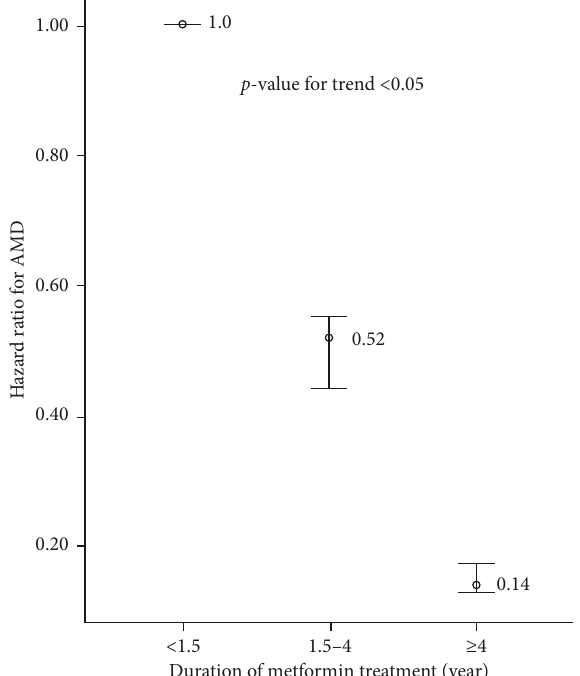
Figure 3: Risk of AMD according to metformin treatment duration. AMD: age-related macular degeneration.